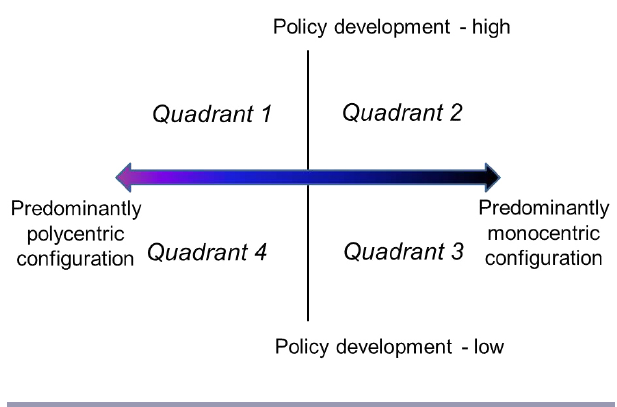
Fig. 1. Quadrants in which different polycentric governance configurations can be placed. The horizontal axis depicts the contrast between different configurations. On the vertical axis, the contrast between limited and advanced policy development is